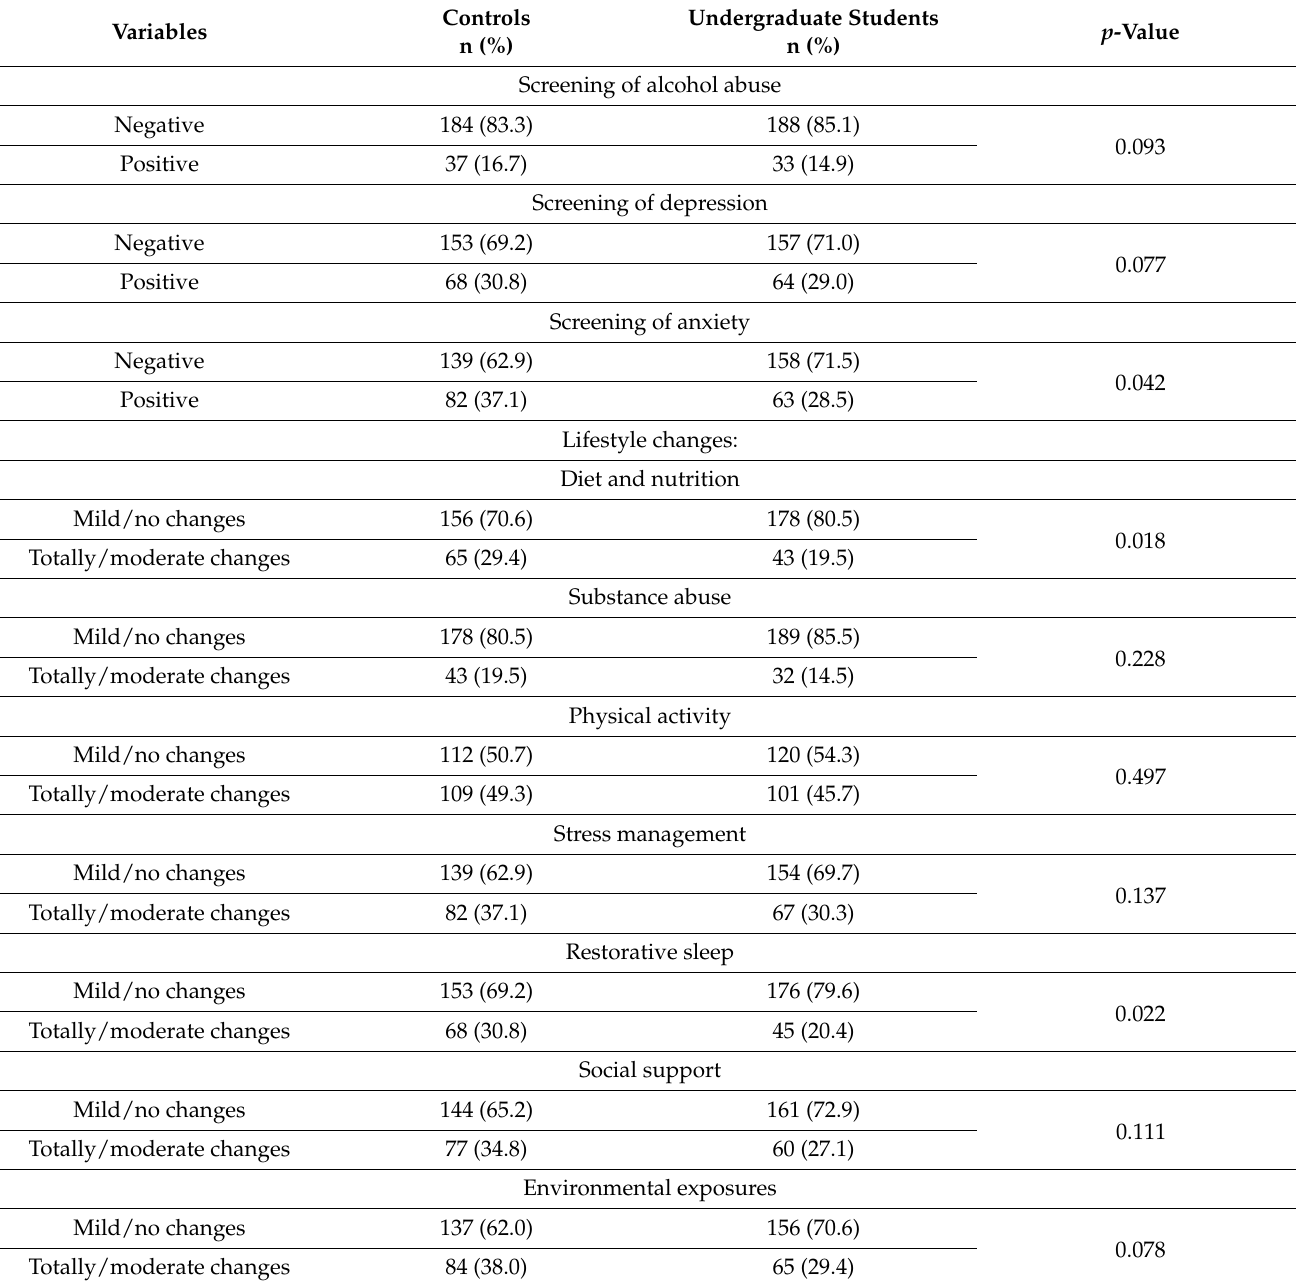
Table 2. Between-group comparison of mental health screenings and lifestyle